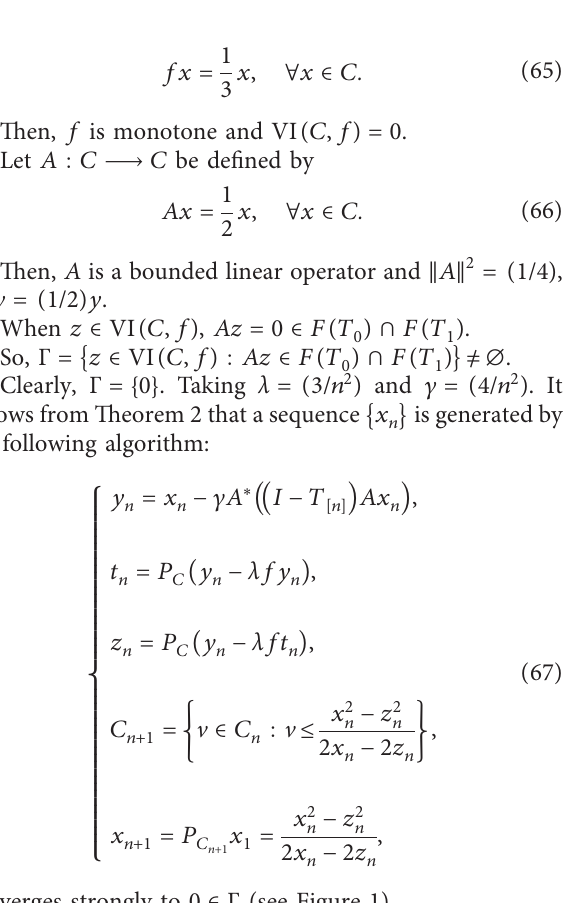
Figure 1: The table and graph of sequence x � 1 . x 0